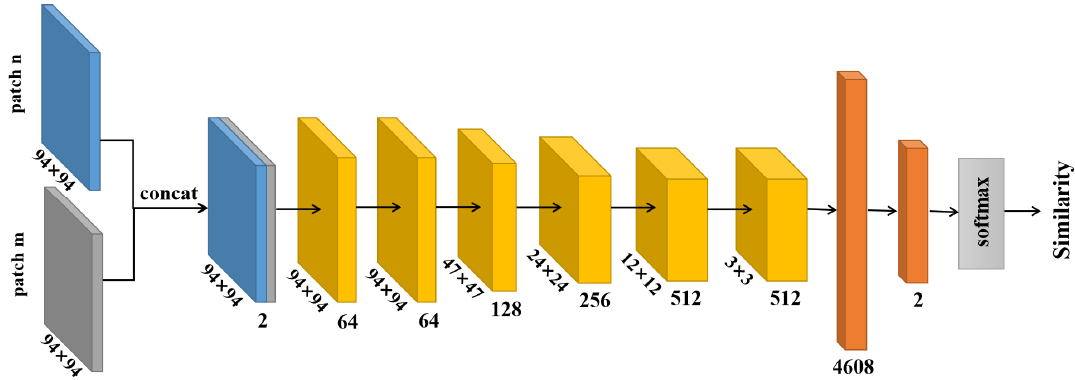
Figure 7. The network structure of the matching layer.